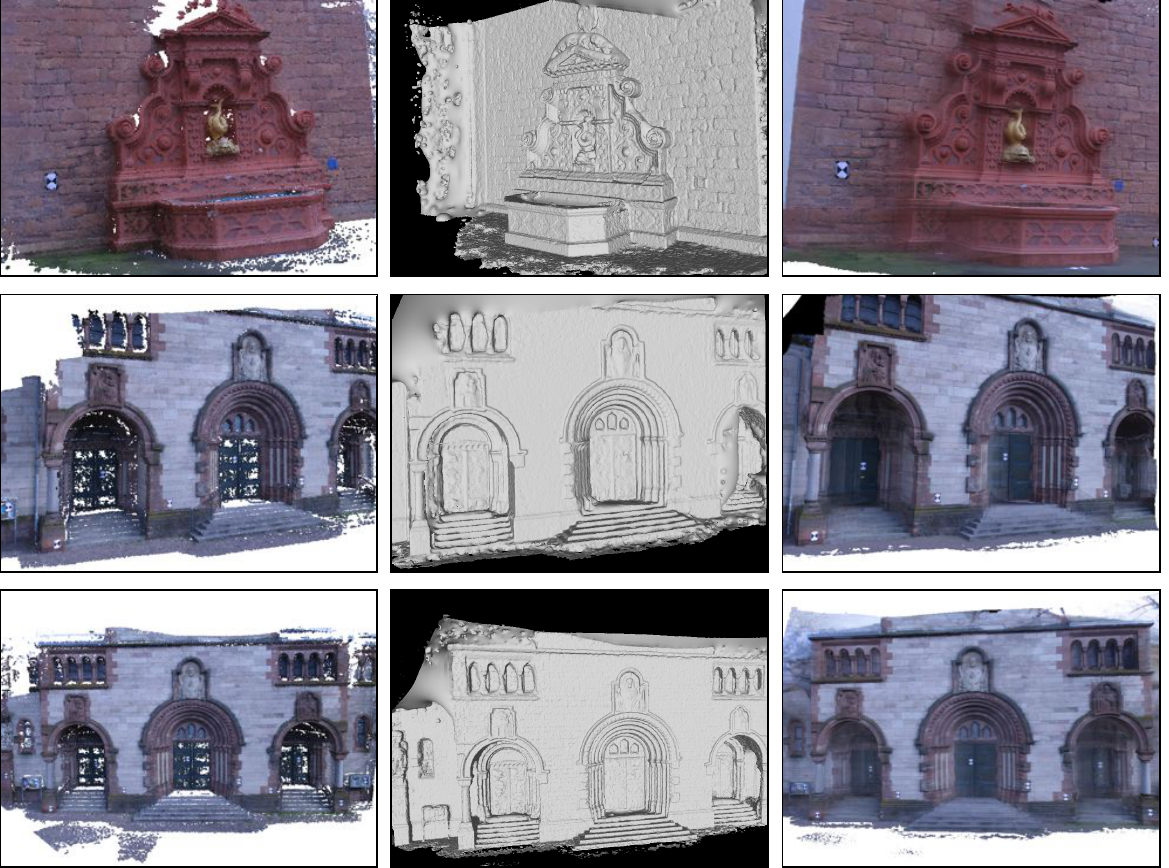
Figure 8: Multiview Stereo Results. From left to right, Stereo Points, Shaded Surfaces and Textured Surfaces are reported. The datasets are, from top to bottom, Fountain-P11, Herz-Jesu-P8, and